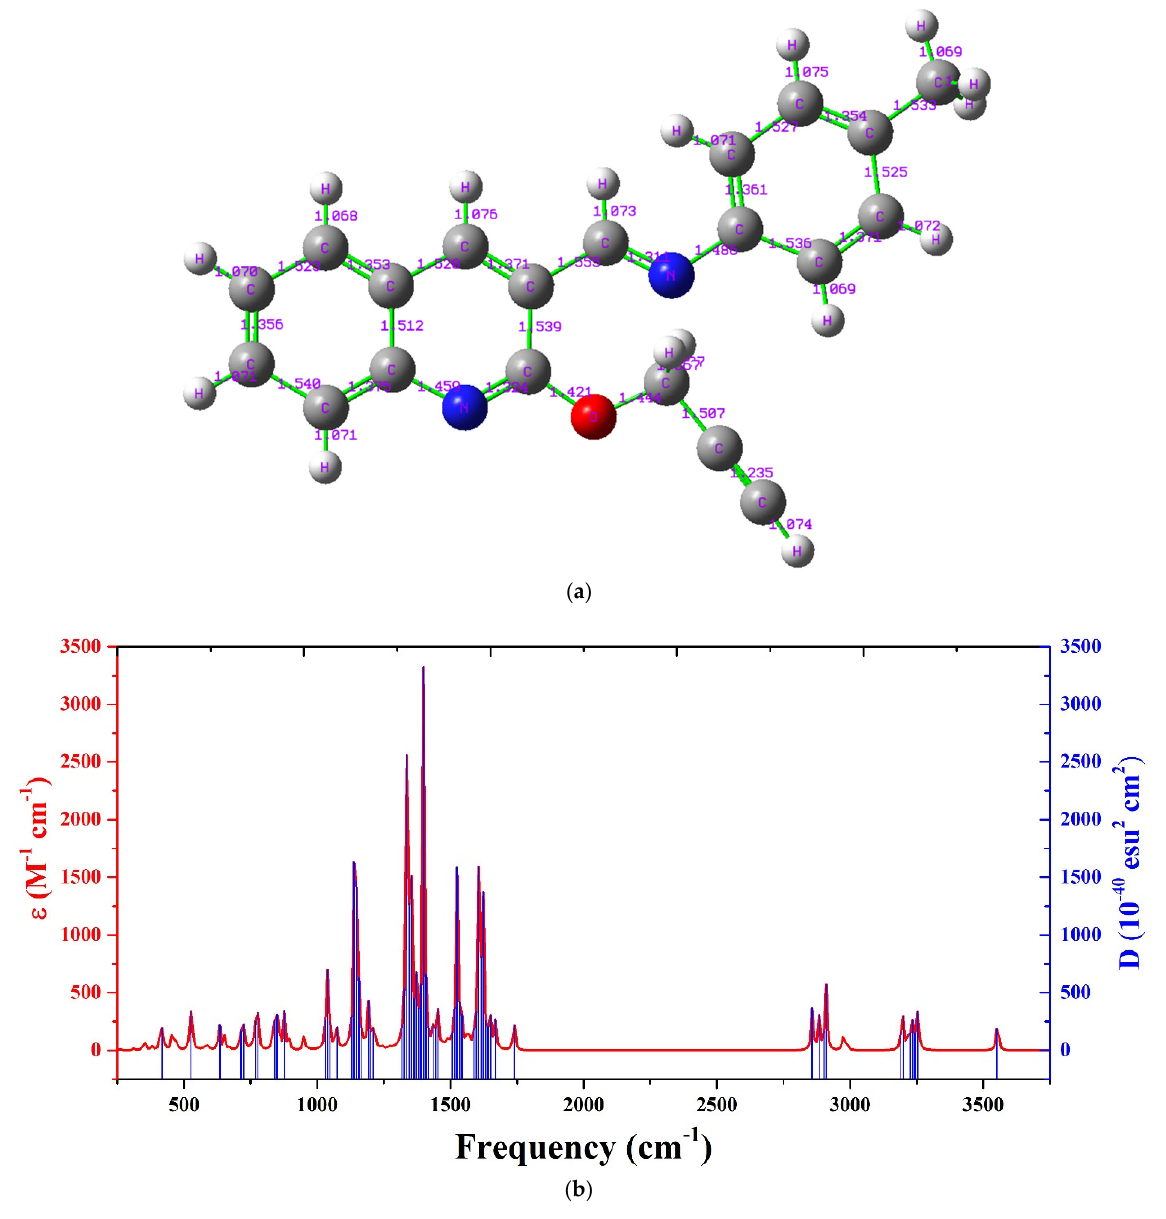
Figure 3. ( a ) Geometry-optimized structure of compound 5d using the TD-DFT B3LYP method with 6–31G* basis set; ( b ) simulated IR spectra of 5d using TD-DFT B3LYP method with 6–31G* basis set. ( a ) shows the optimized structure and ( b ) shows the infra-red (IR) spectra of 5d .